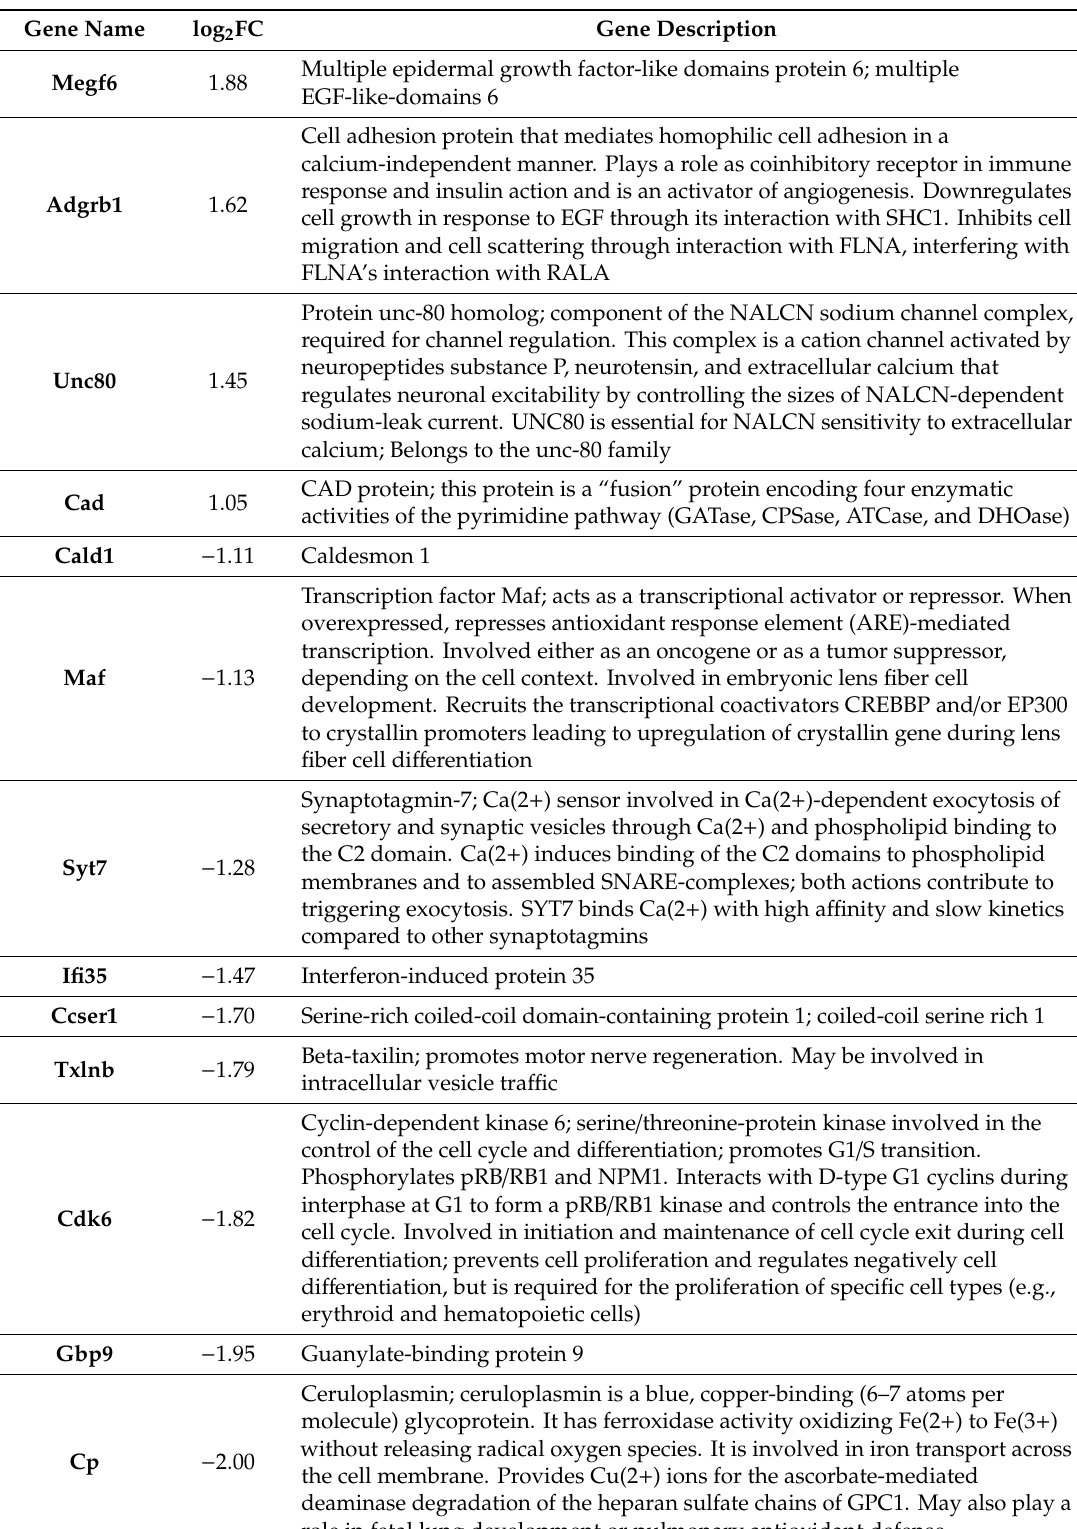
Table 4. Gene description and fold change of deregulated RNAs after transcriptome